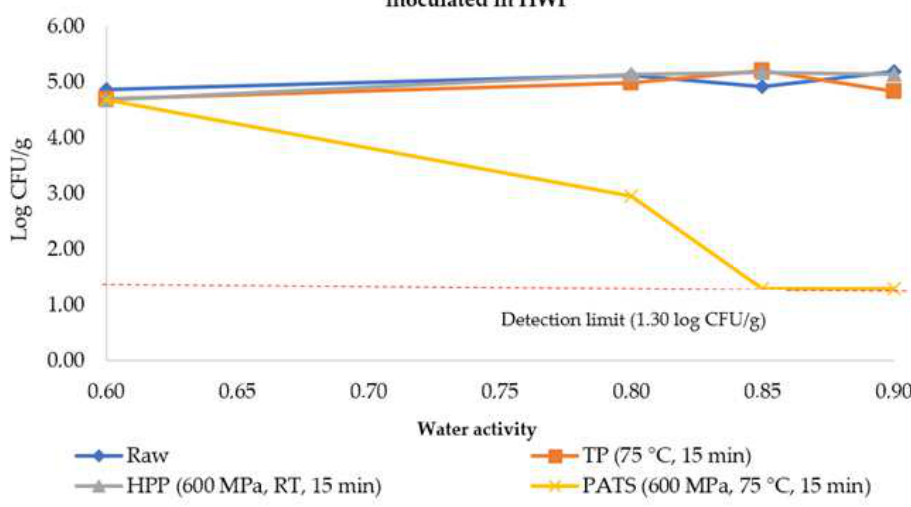
Figure 4. Impact of HPP (600 MPa for 15 min at room temperature), PATP (600 MPa, 75°C, 15 min), and conventional thermal pasteurization (TP) (75°C for 15 min) on the survival of B. subtilis endospores in whole (a W = 0.60) and HWP (honey–water preparations) with an adjusted water activity (a W up to 0.90).